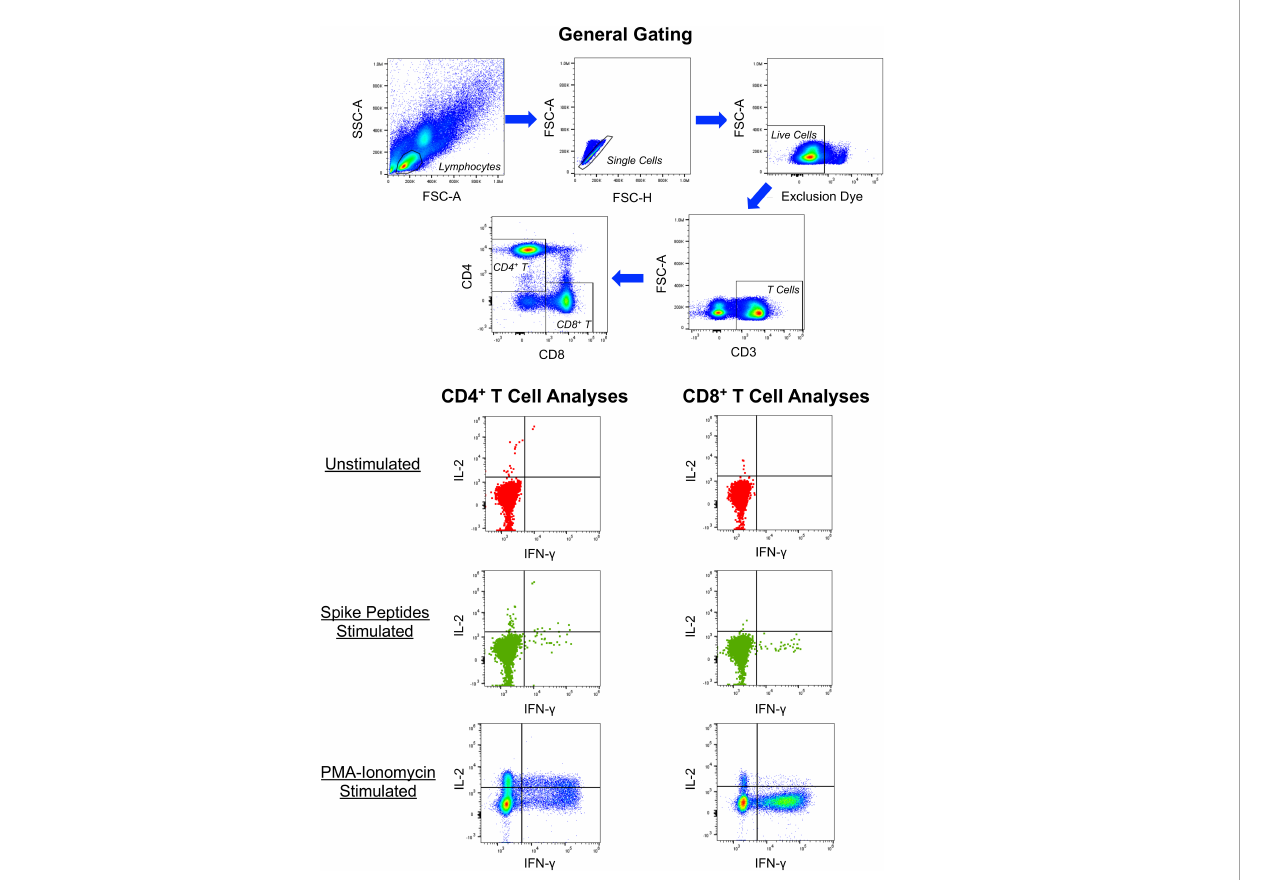
FIGURE 2 Example of intracellular cytokine staining for CD4 + and CD8 + T cell responses against SARS-CoV-2 spike. PBMC from a person 13 days after symptom onset of COVID-19 were cultured in the absence or presence of overlapping 15-mer synthetic peptides spanning the SARS-CoV-2 spike protein and assessed for production of IFN- g , IL-2, IL-10 (not shown) and IL-4 (not shown) by intracellular cytokine staining and fl ow cytometry. Controls included cells cultured without peptides and PMA-ionomycin stimulated